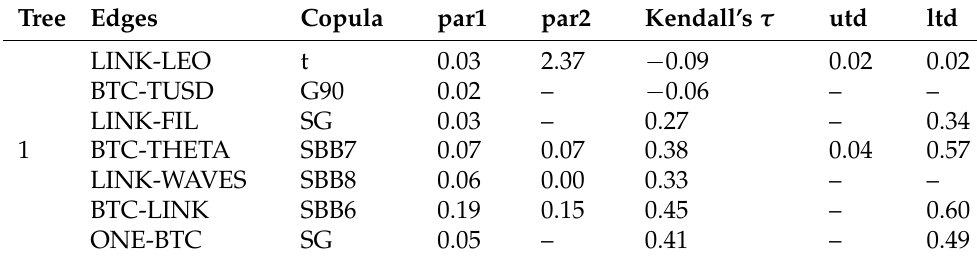
Table 8. Parameter estimate of R-vine copula. Tree